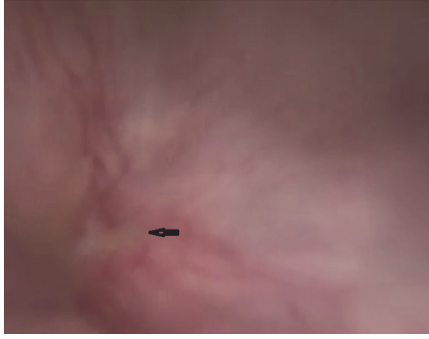
Figure 2: Fistula orifice in the bladder with cystoscopy.